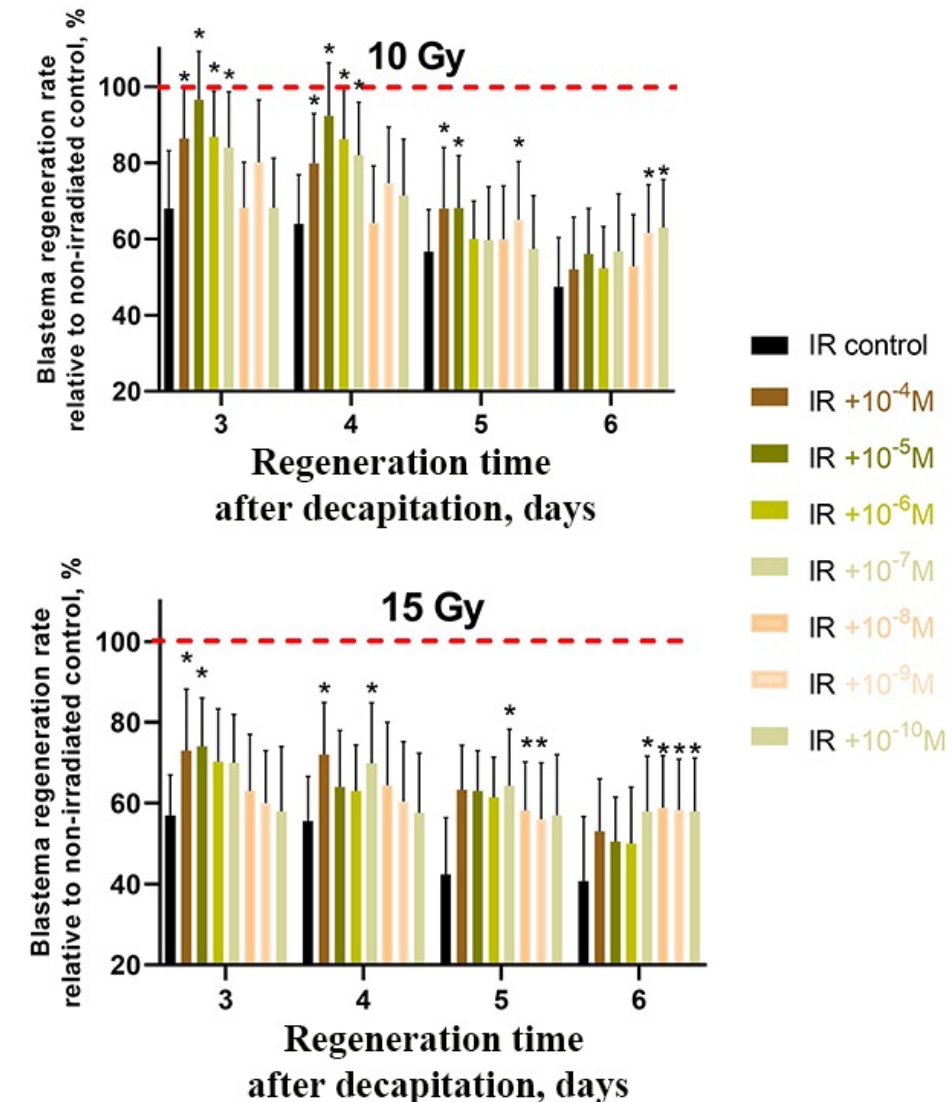
Figure 3. Radioprotective effect of CeO 2 nanoparticles on regenerating planarian blastemas after X-ray irradiation (10 Gy and 15 Gy). Brown to light-brown bars represent the percentage of blastema regeneration rate; the regeneration rate of non-irradiated animals was taken as 100% (red line). * p < 0.05 (difference from the control group). M ± SD, n = 90. IR — X-ray irradiation.